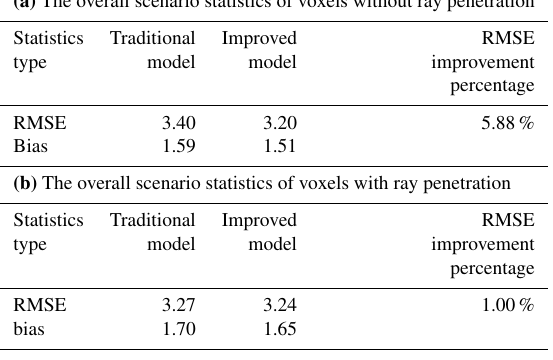
Table 5. Statistics of two models’ tomography accuracy with re- spect to ECMWF data in the voxels with and without penetrating GNSS rays for the experimental period (unit: gm − 3